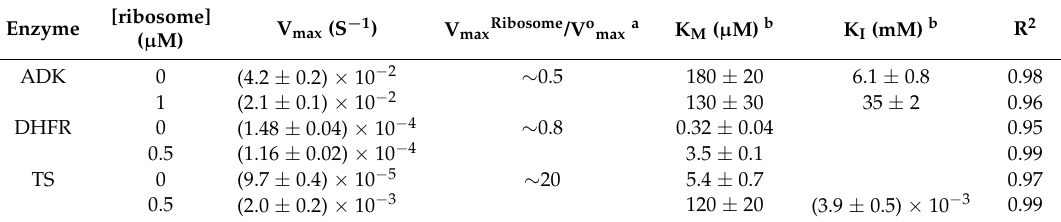
Table 2. Kinetic Parameters Resolved for ADK, DHFR and TS in the Absence and Presence of